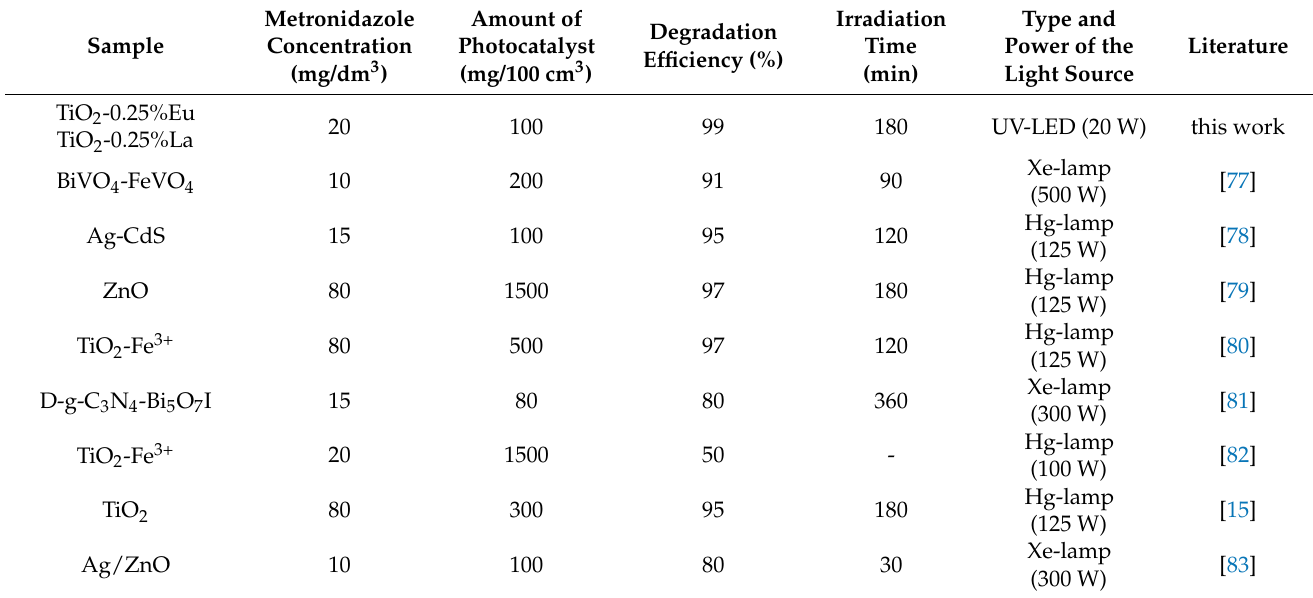
Table 5. Summary of literature data on the degradation of metronidazole.